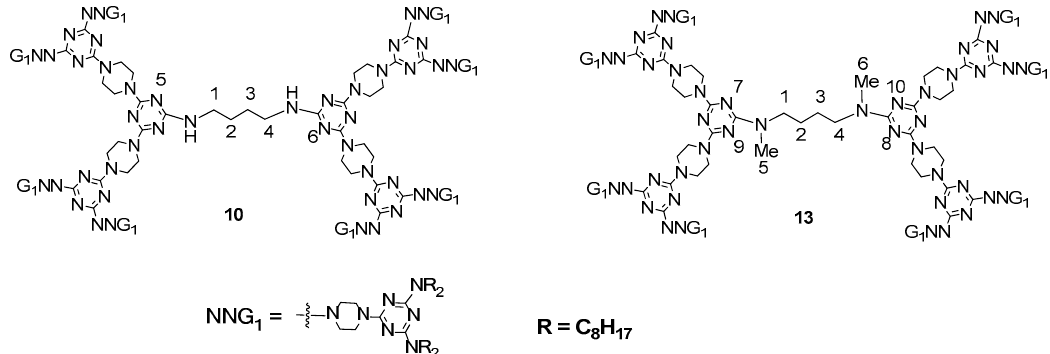
Figure 9. The numbering on carbons for indicating intramolecular H-bond interactions between H and N of dendrimers ( 10 ) and ( 13 ).